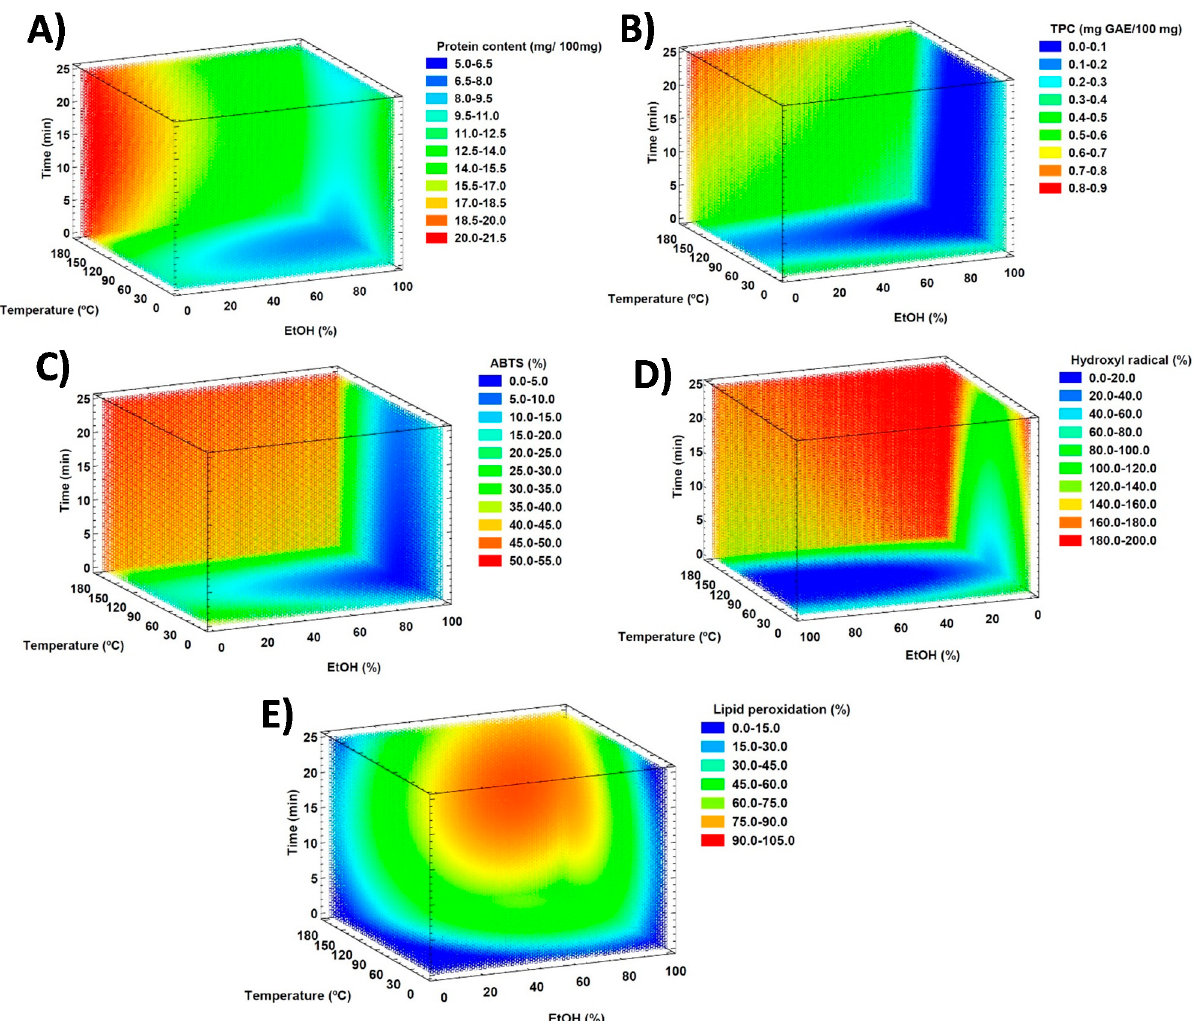
Figure 2. 3D contour plots illustrating the effect of the extraction time, the extraction temperature, and the percentage of EtOH in the extraction yield of proteins ( A ), in the TPC ( B ), and in the capacity to scavenge free radicals ( C ), to avoid the formation of hydroxyl radicals ( D ), and to inhibit lipid peroxidation ( E ). Table 2. Conditions predicted by Box–Behnken experimental design for obtaining the highest pro- tein yield, TPC, scavenging of ABTS and DPPH radicals, inhibition of hydroxyl radical formation, reducing power, and inhibition of lipid peroxidation by PLE and protein content and TPC deter- mined in extracts.